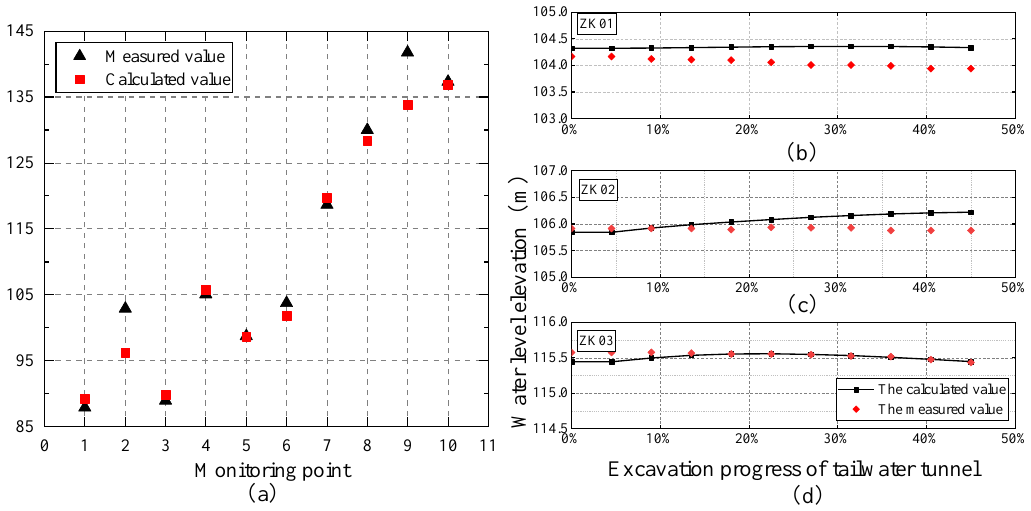
Figure 9. Comparison of the measured water level and the calculated water level. (( a ) is comparison of measured and calculated groundwater flow field values, ( b ) is comparison of measured and calculated water level in long—term observation hole ZK01, ( c ) is comparison of measured and calculated water level in long—term observation hole ZK02, ( d ) is comparison of measured and calculated water level in long—term observation hole ZK03).